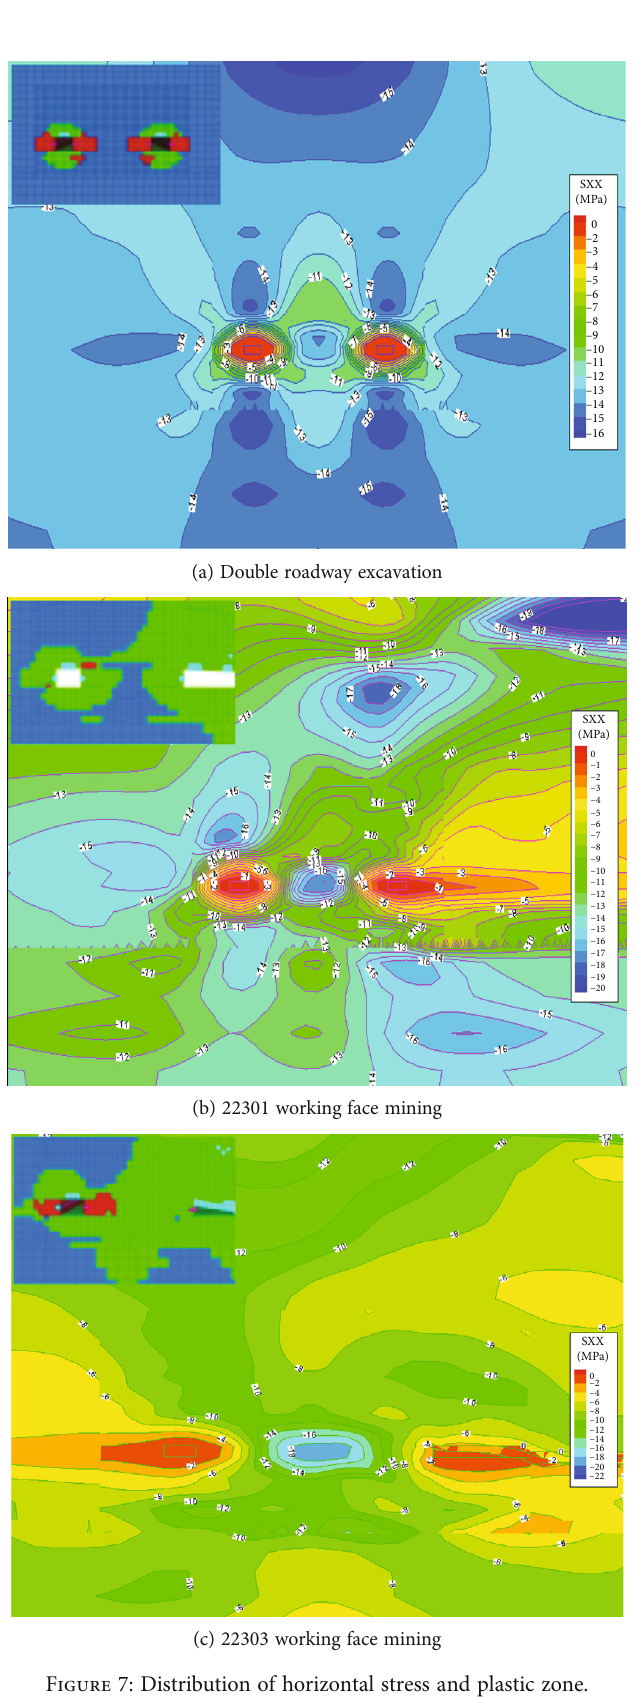
Figure 7: Distribution of horizontal stress and plastic